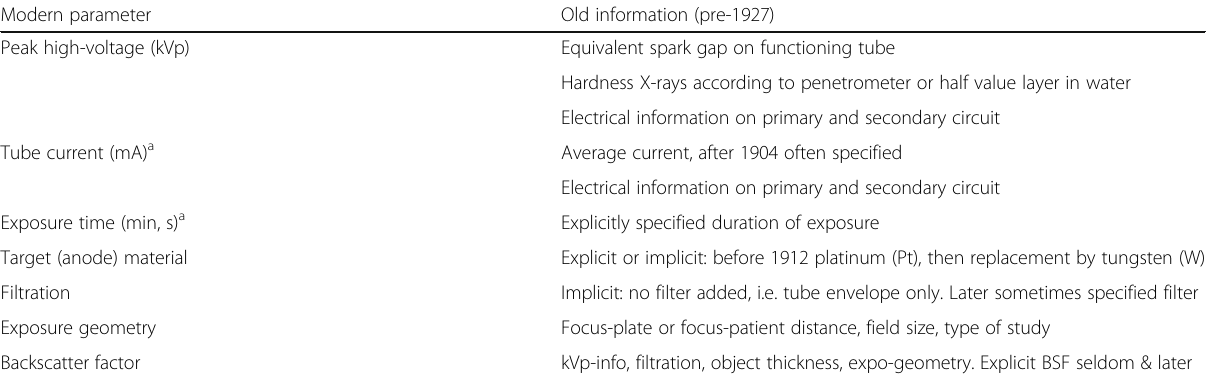
Table 1 Parameters relevant in characterizing historical radiographs Modern parameter